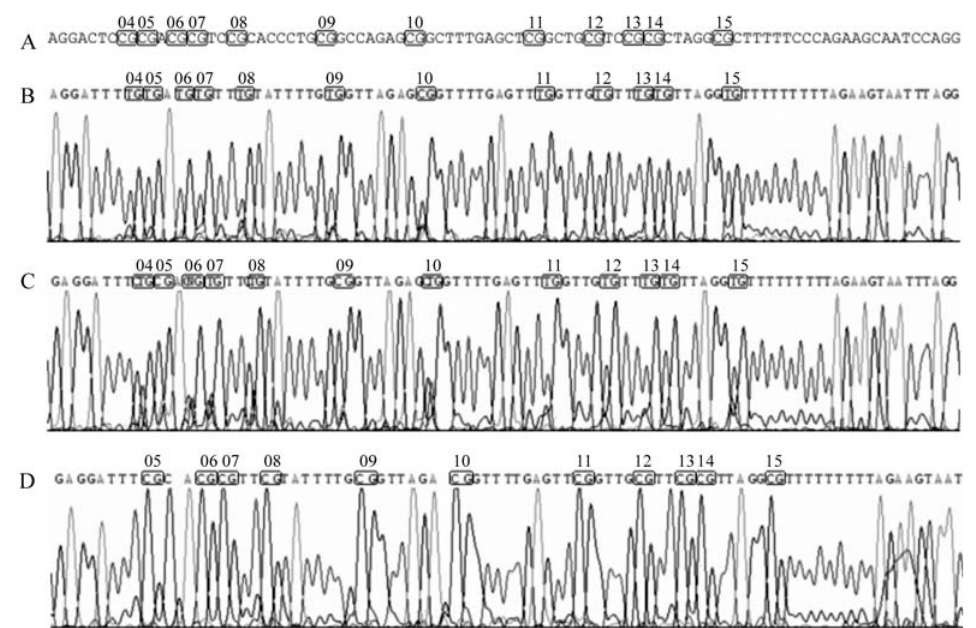
Figure 5 - Chromatogram of the direct bisulfite sequencing from CpG 4 to CpG 15 of the region: (A) Original sequence. (B) Sample IX, unmethylated. (C)SampleXIX,hemimethylated.(D)SampleII,methylated.TheCpGdinucleotidesarehighlighted.Afterbisulfitetreatment,theCpGdinucleotidesre- mained as such in the methylated samples, but were converted to TpG in the unmethylated samples. In the hemimethylated samples, some CpG dinucleotides were converted but others